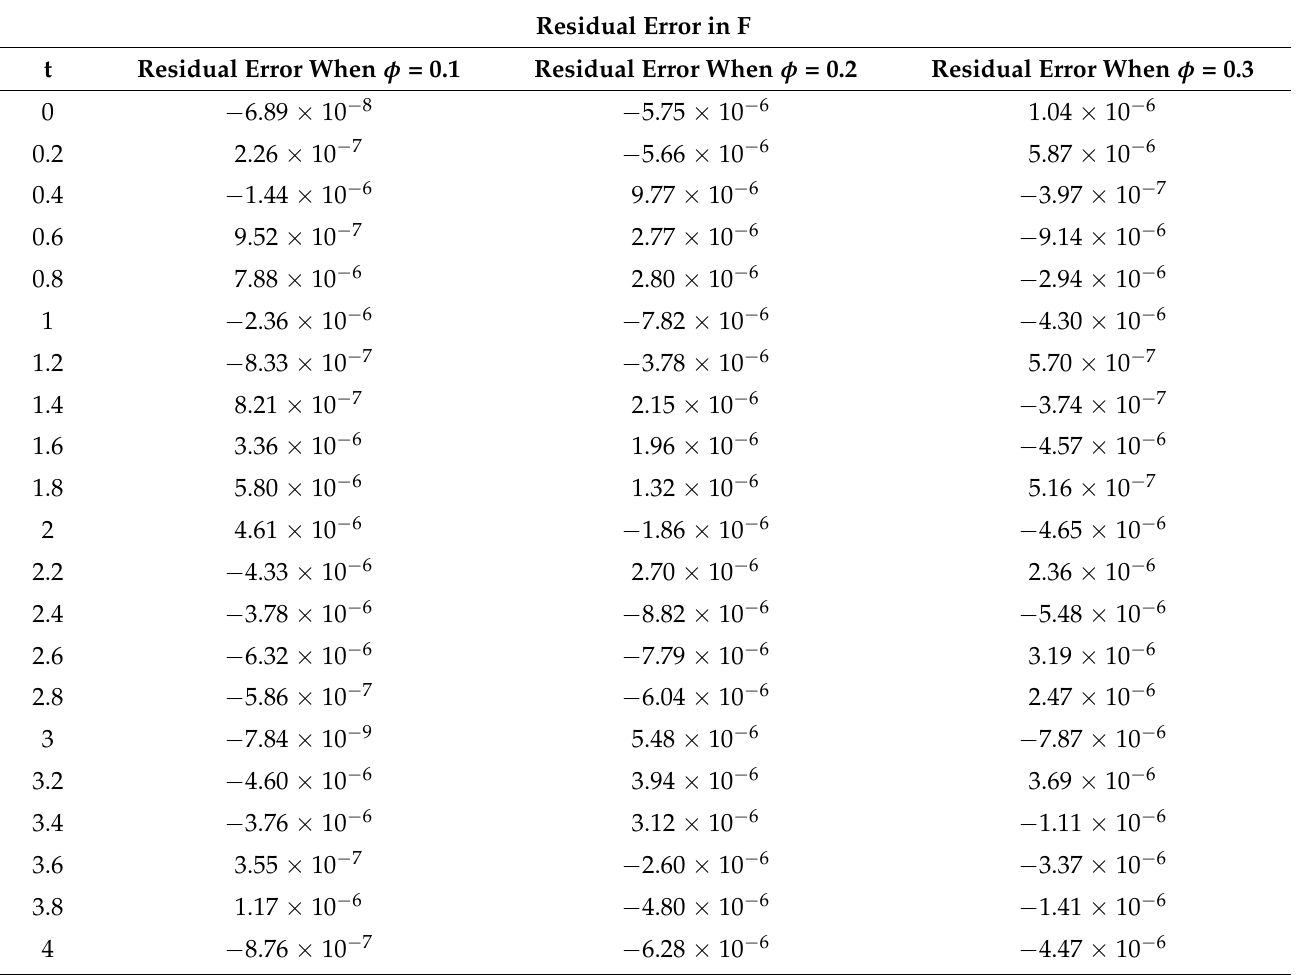
Table 15. The residual error in F when φ varies are shown in the